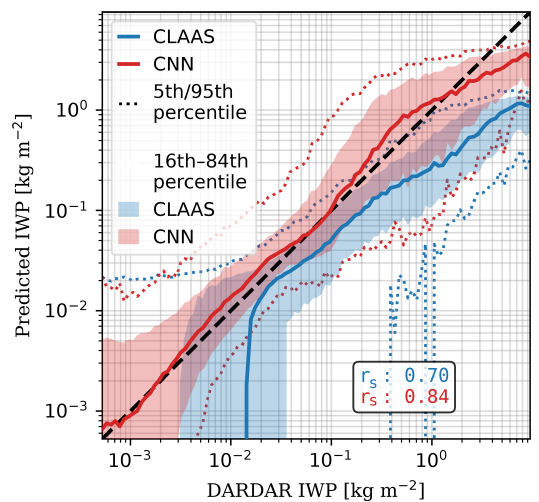
Figure 9. IWP predictions from our approach (QRNN with CNN architecture, IR input settings) and from CLAAS. The QRNN is trained with daytime and nighttime observations, but the test data in both cases contain only daytime observations. The QRNN expected value is used as its retrieval estimate. The solid curves indicate the median value of each measure at the local DARDAR IWP. Sum- mary statistics in kgm − 2 . Predictions and statistics computed for all test set samples also available in CLAAS.